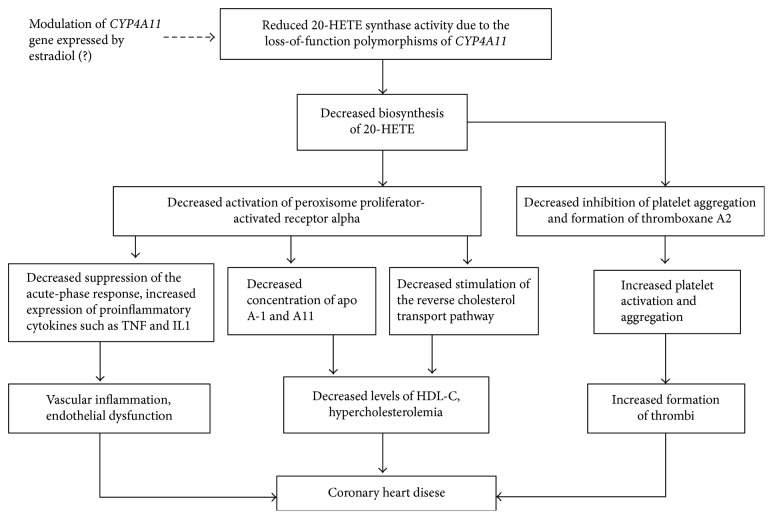
Proposed mechanisms by which the loss-of-function polymorphisms of the CYP4A11 gene are involved in the pathogenesis of coronary heart disease (see the text for details).